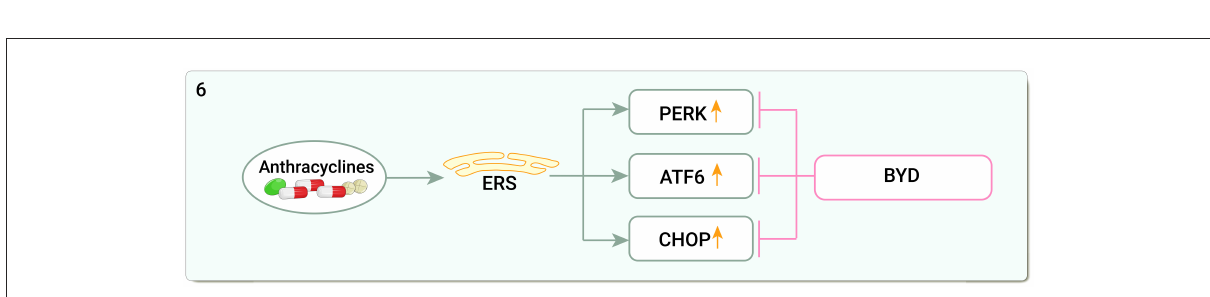
FIGURE6 Traditional Chinese medicine alleviates cardiotoxicity associated with chemoradiotherapy by inhibiting endoplasmic reticulum stress (ERS, Endoplasmic reticulum stress; PERK, The stress protein kinase R-like endoplasmic reticulum kinase; ATF6, Activating transcription factor 6; CHOP:C/EBP homologous protein; BYD, Baoyuan